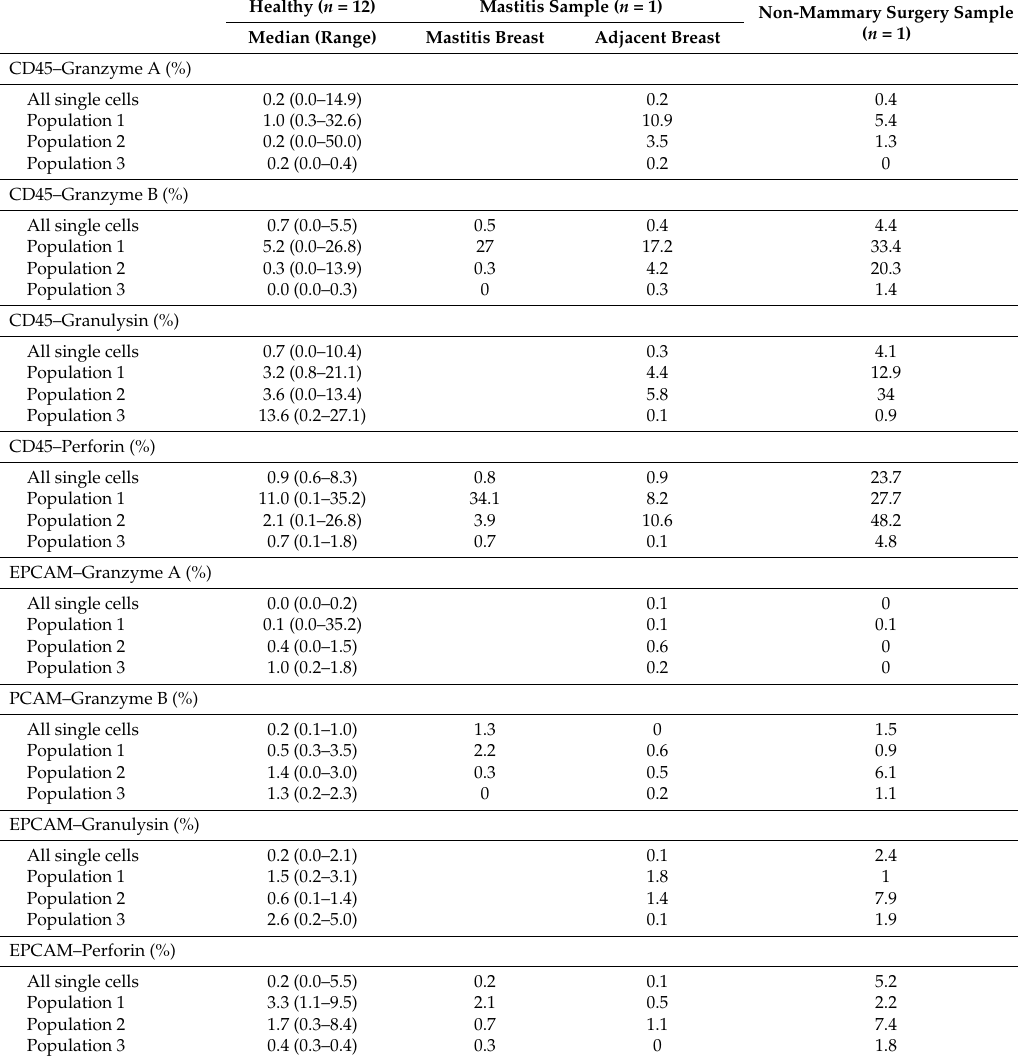
Table 3. Flow cytometric analysis of immune and epithelial cell proteins in HM cells (%) taken from healthy, mastitis and non-mammary post-surgery participants. Double stainings between either CD45 or EPCAM positive cells and immune